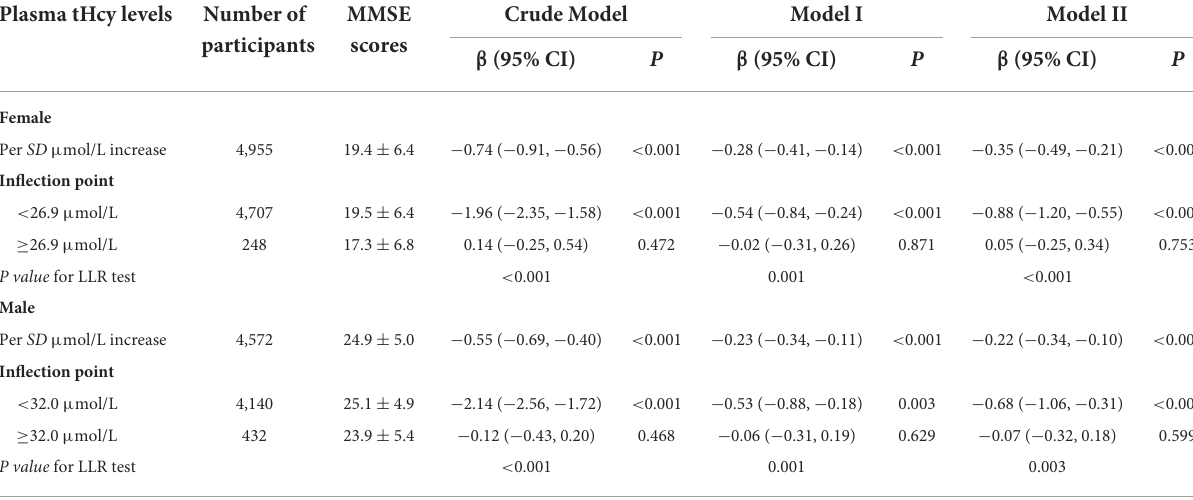
TABLE 3 Threshold effect analysis of plasma tHcy levels on MMSE scores using piece-wise binary linear regression models by sex. Plasma tHcy